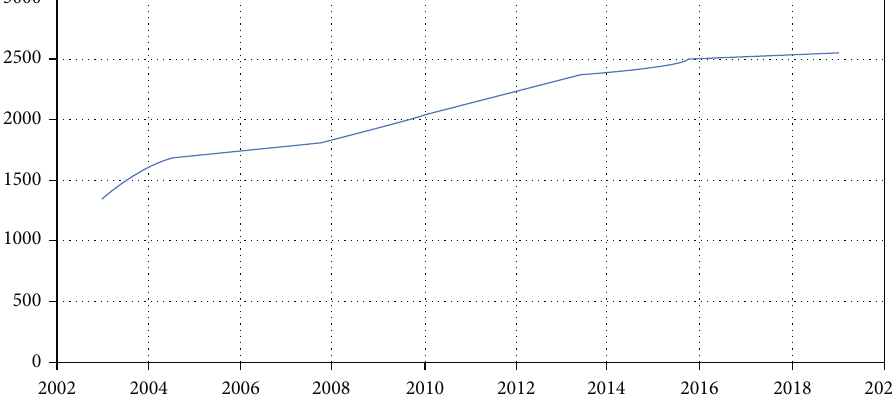
Figure 3: Milk production in millions of